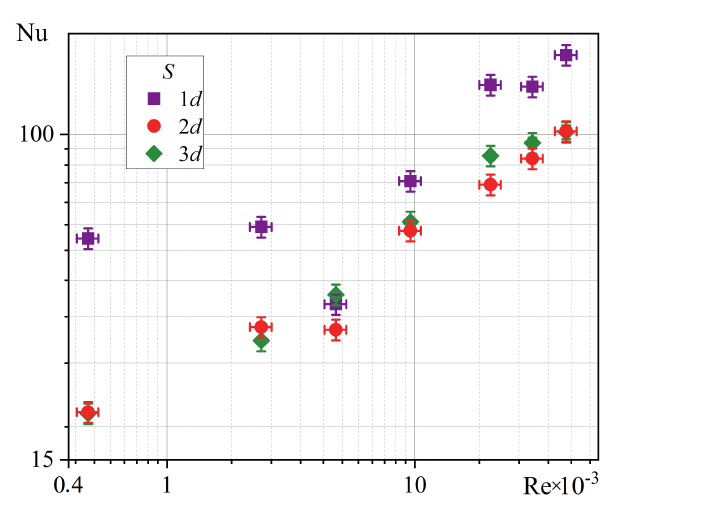
Figure 16. Dependence of the surface-averaged Nusselt number for the third cylinder from regime. According to our data, the distance S = d is the most effective for heat transfer on the third cylinder. For all Re and S , the average Nusselt number over the third cylinder is greater than for the